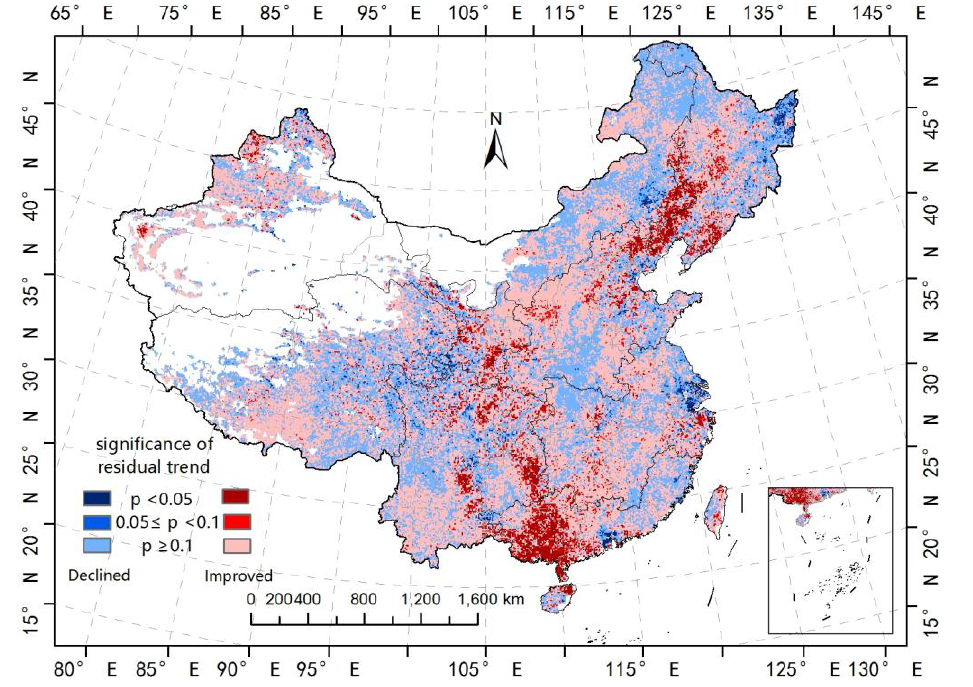
Figure 8. Significance of slopes of linear regression residuals based on t